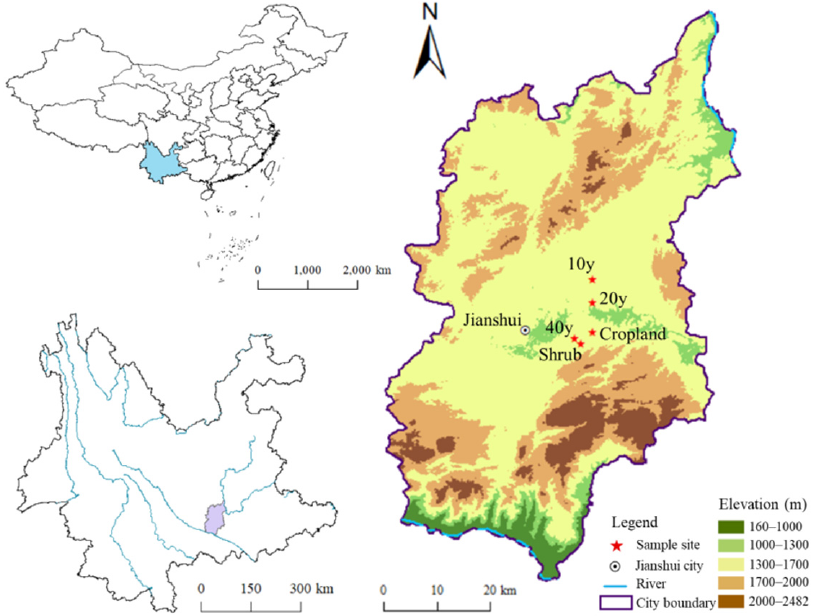
Figure 1. Location of the study area.